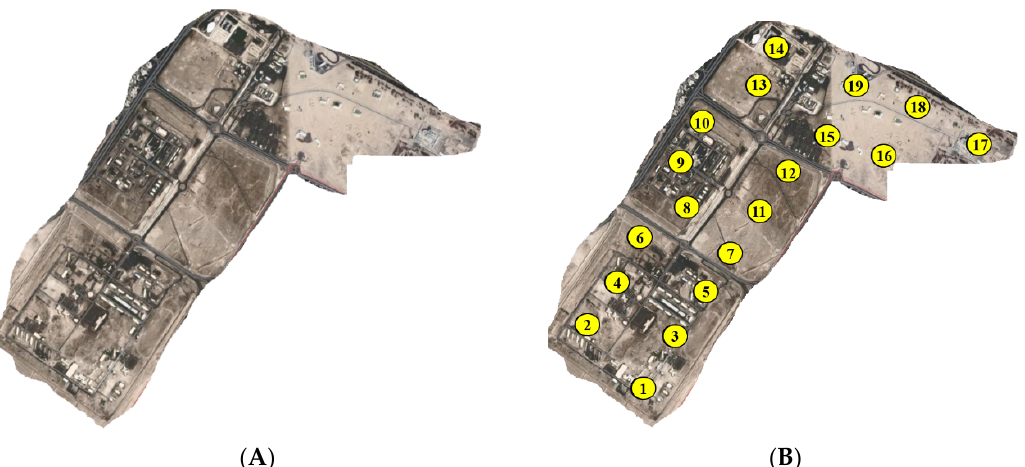
Figure 6. ( A ) Region examined in the case example; ( B ) available locations for placing buildings in the region.